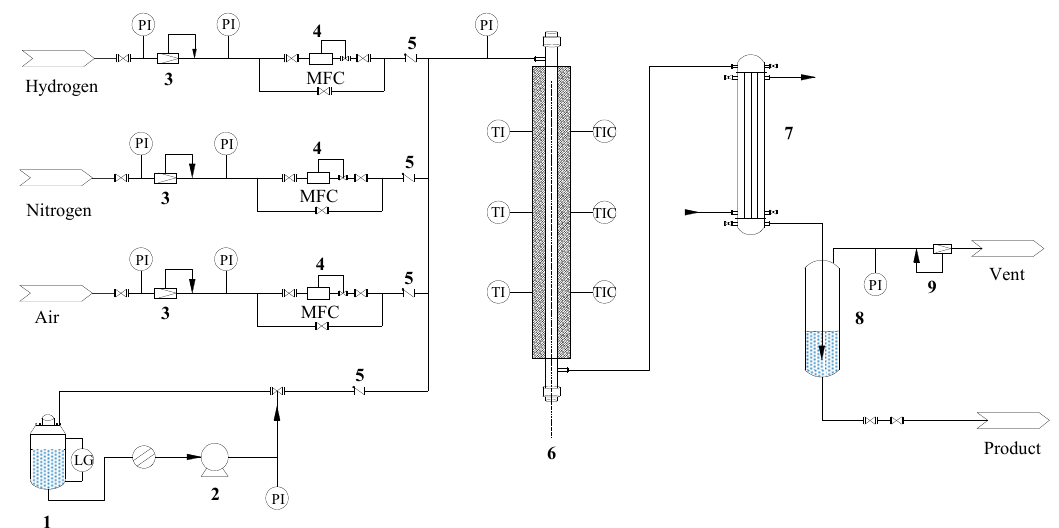
Figure 13. PID (Piping & Instrument Diagram) diagram of the experimental device of n-heptane isomerization. 1 feedstock tank, 2 feed pump, 3 pressure reducing valve, 4 mass flowmeter, 5 check valve, 6 reactor, 7 loop condenser, 8 products tank, and 9 back pressure valve.